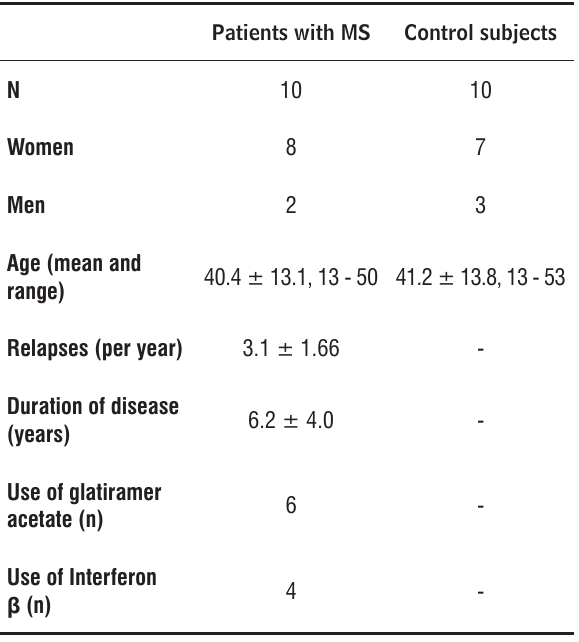
Table 1 - General characteristics of the study participants Patients with